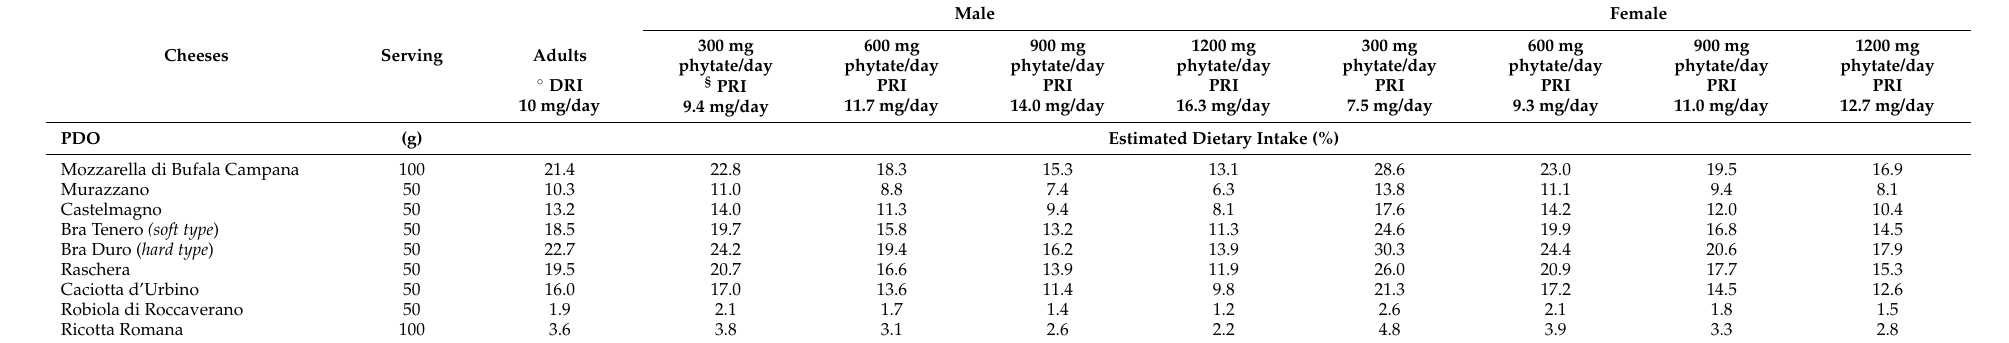
Table 6. Estimated Dietary Intake (%) of zinc in adults calculated according to the reference values of EU [28] and EFSA [13], with a serving (50 g or 100 g) of cheese from buffalo milk, from mixed milk, and from sheep whey.